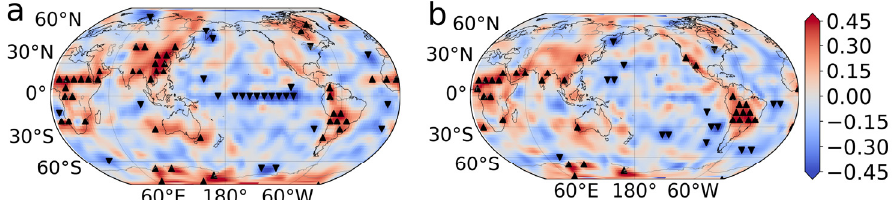
Figure 3. Tendency of ( a ) in-degree and ( b ) out-degree from 1949 to 2020. Colors represent the Pearson correlation coefficient between the degree and year. The black upper triangle indicates that the degree time series at this node is significantly increased with year, and the black lower triangle indicates that it is significantly decreased according to the MK test with the 99% confidence level.